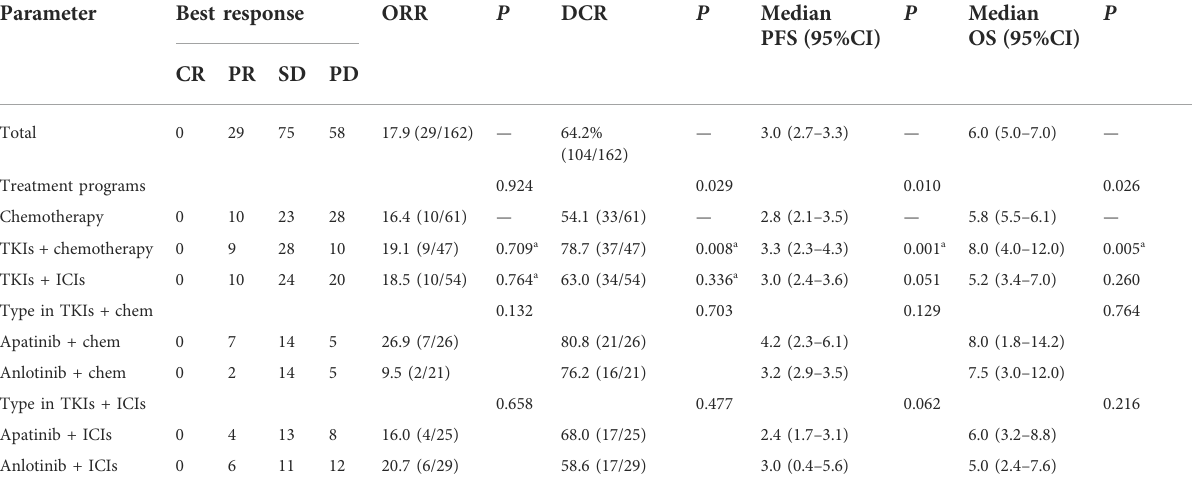
TABLE 3 Ef fi cacy of chemotherapy, TKIs + chemotherapy and TKIs + ICIs in patients with advanced or metastatic gastric cancer.